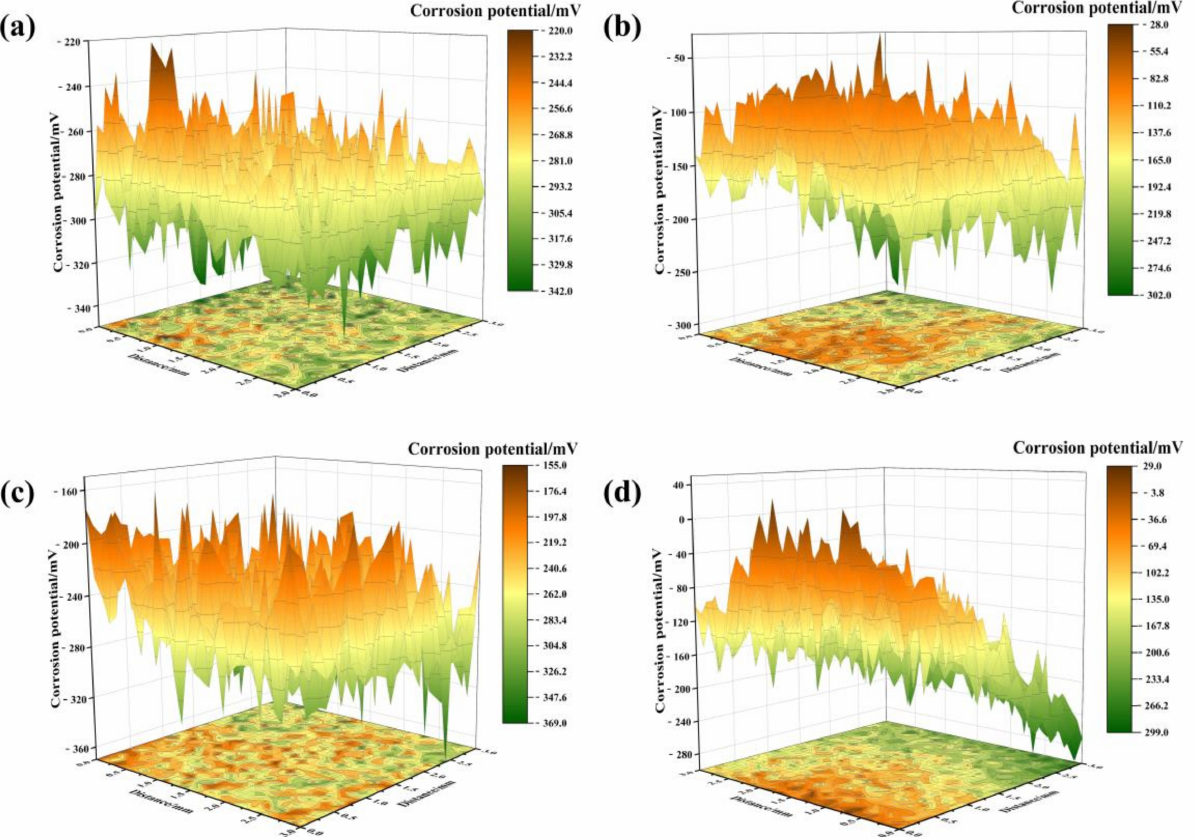
Figure 4. Kelvin potential profiles measured after pitting corrosion in state R ( a , b ) and state I ( c , d